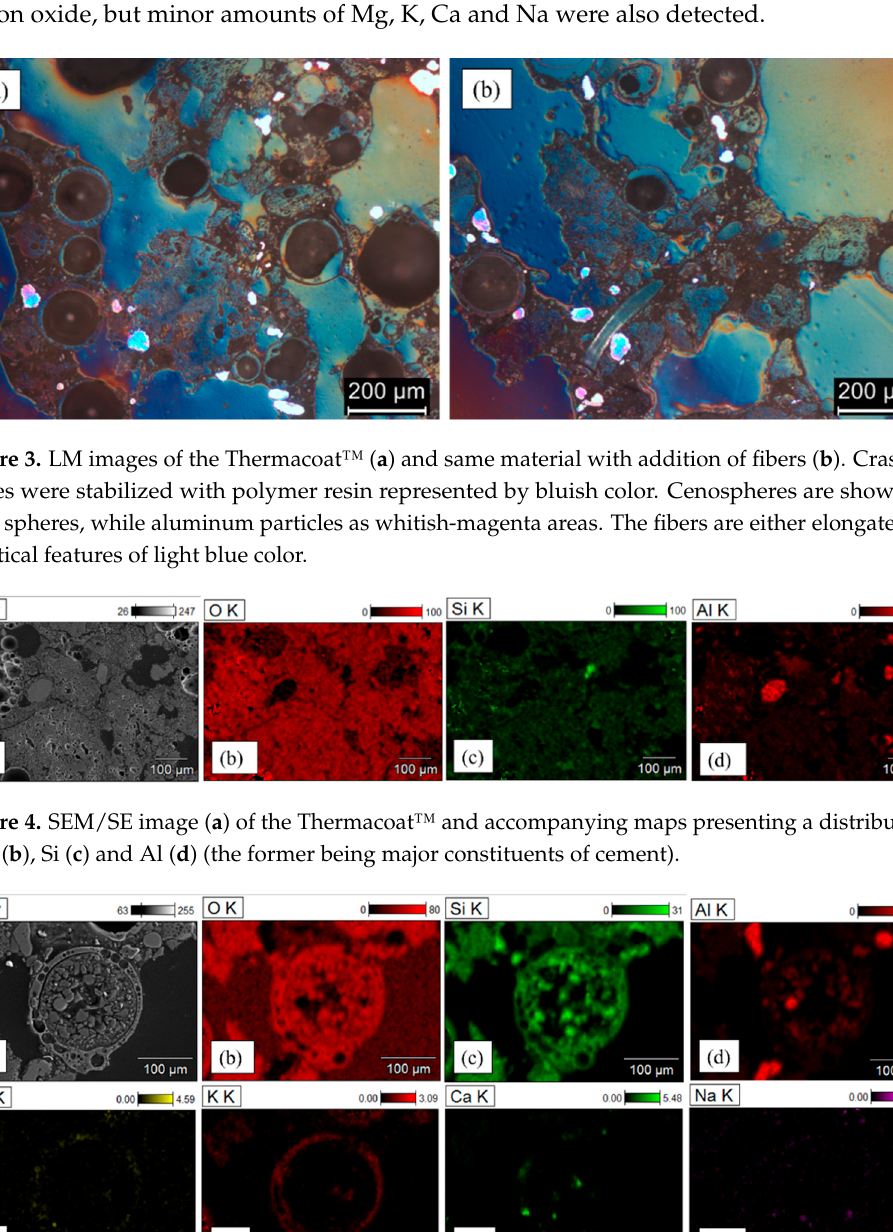
Figure 4. SEM/SE image ( a ) of the Thermacoat™ and accompanying maps presenting a distribution of O ( b ), Si ( c ) and Al ( d ) (the former being major constituents of cement).